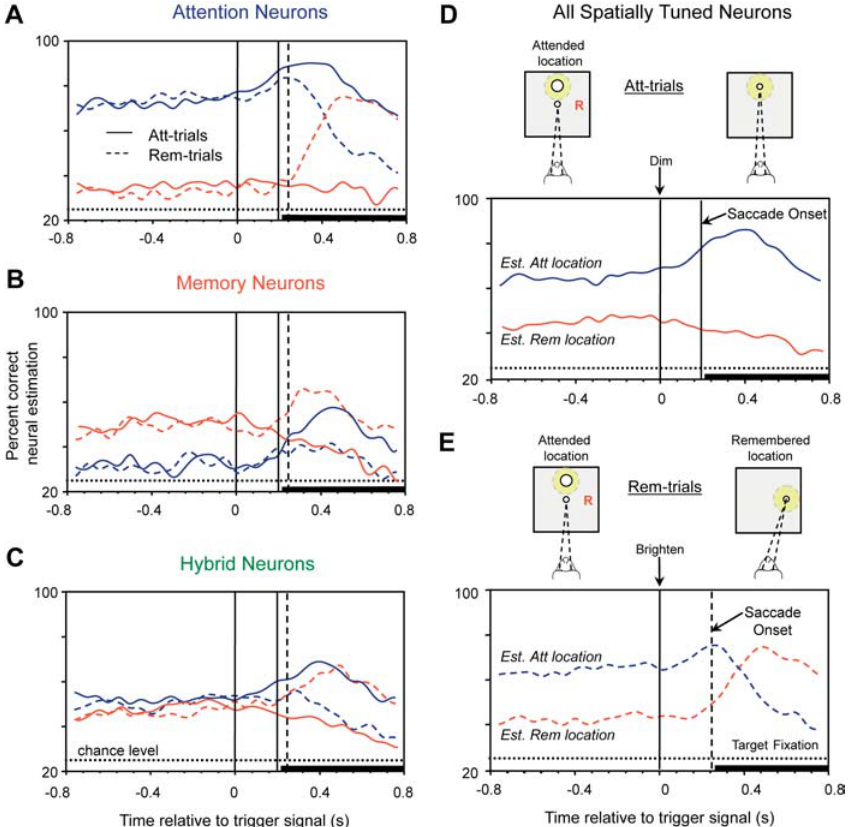
Figure 8. Time-Dependent Changes in Estimating the Attended Location and Remembered Location, for Both Monkeys Combined Solid lines, trials in which the monkeys made a saccade to the attended location; dashed lines, trials in which the monkey made a saccade to the remembered location. Blue lines, estimation of the attended location; red lines, estimation of the remembered location. All records are centered on the onset of the trigger signal (using data for the 200 ms prior to that time). Vertical lines at t . 0 show the average saccade latency on Att-trials (solid) and Rem-trials (dashed). The